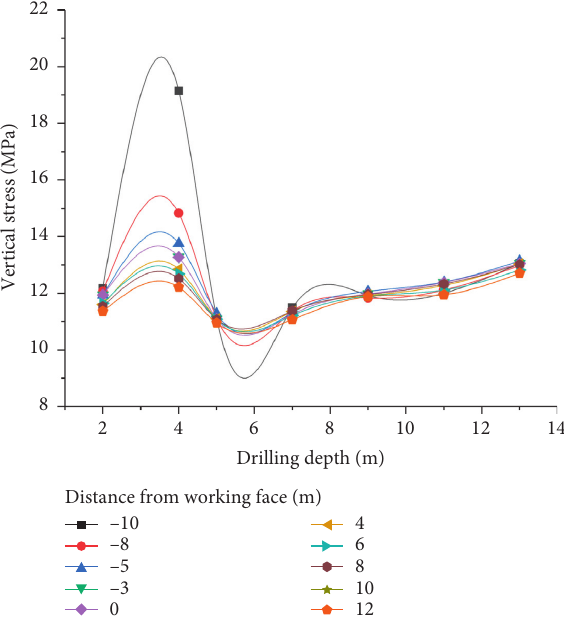
Figure 27: Variation trend of lateral abutment